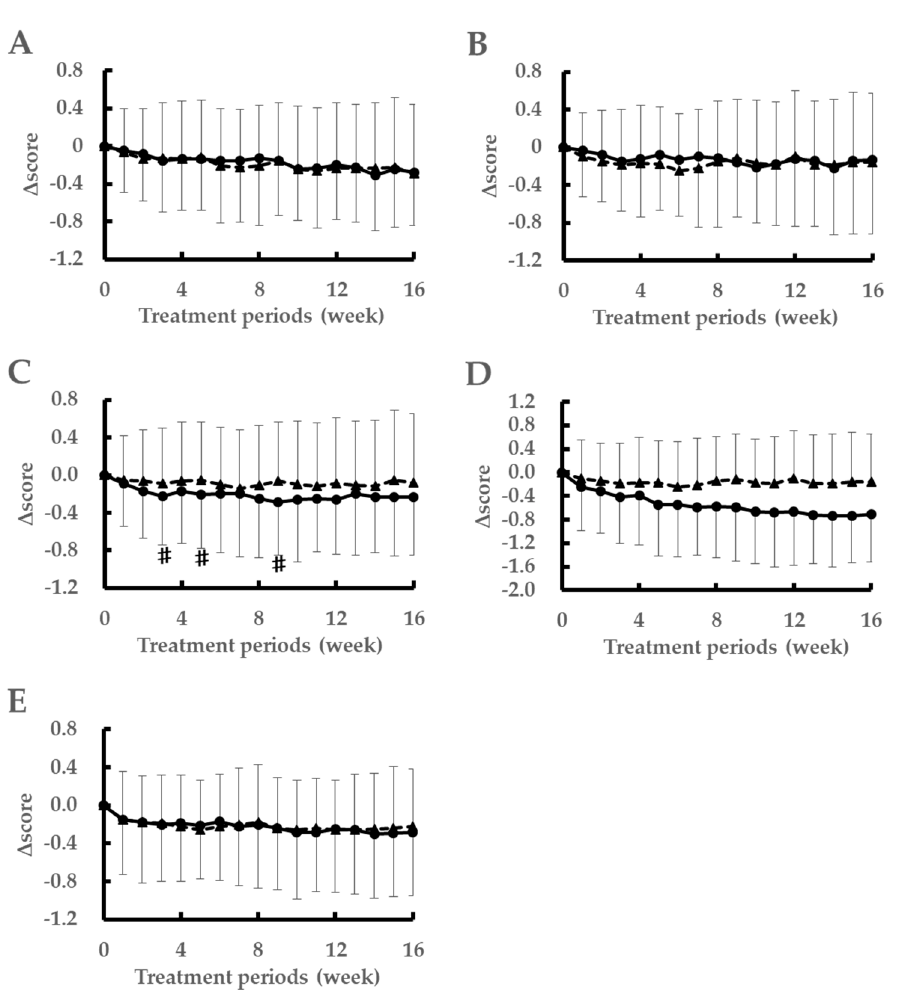
Figure 2. Weekly changes in the subjective symptoms scores according to the subjects’ diaries. Data are expressed as the mean ± standard deviation. # p < 0.05 versus the placebo group as per the Mann- Whitney U test. ● ; LH2171 group, ▲ ; placebo group. ( A ) sneezing, ( B ) runny nose, ( C ) nasal blockage, ( D ) eye itching, ( E )